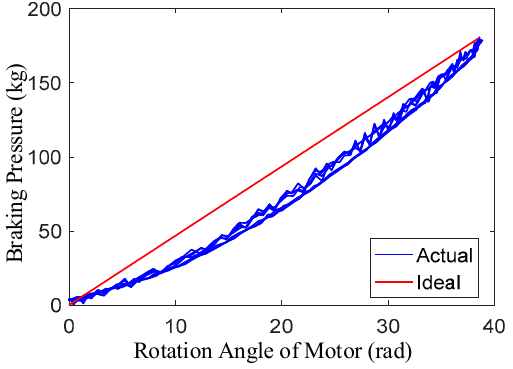
Figure 2. The ideal and actual curves between the braking pressure and the motor position.